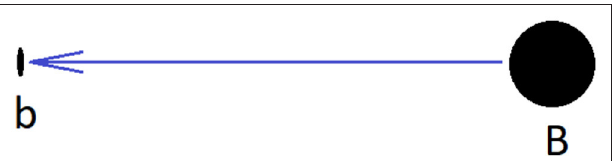
FIGURE 6 | Toy model involving a big and little ball. The big ball represents the boundary and little ball represents the particle. The big ball remains non-relativistic while the little ball quickly become relativistic.